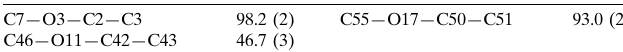
Selected torsion angles ( (cid:1) ).